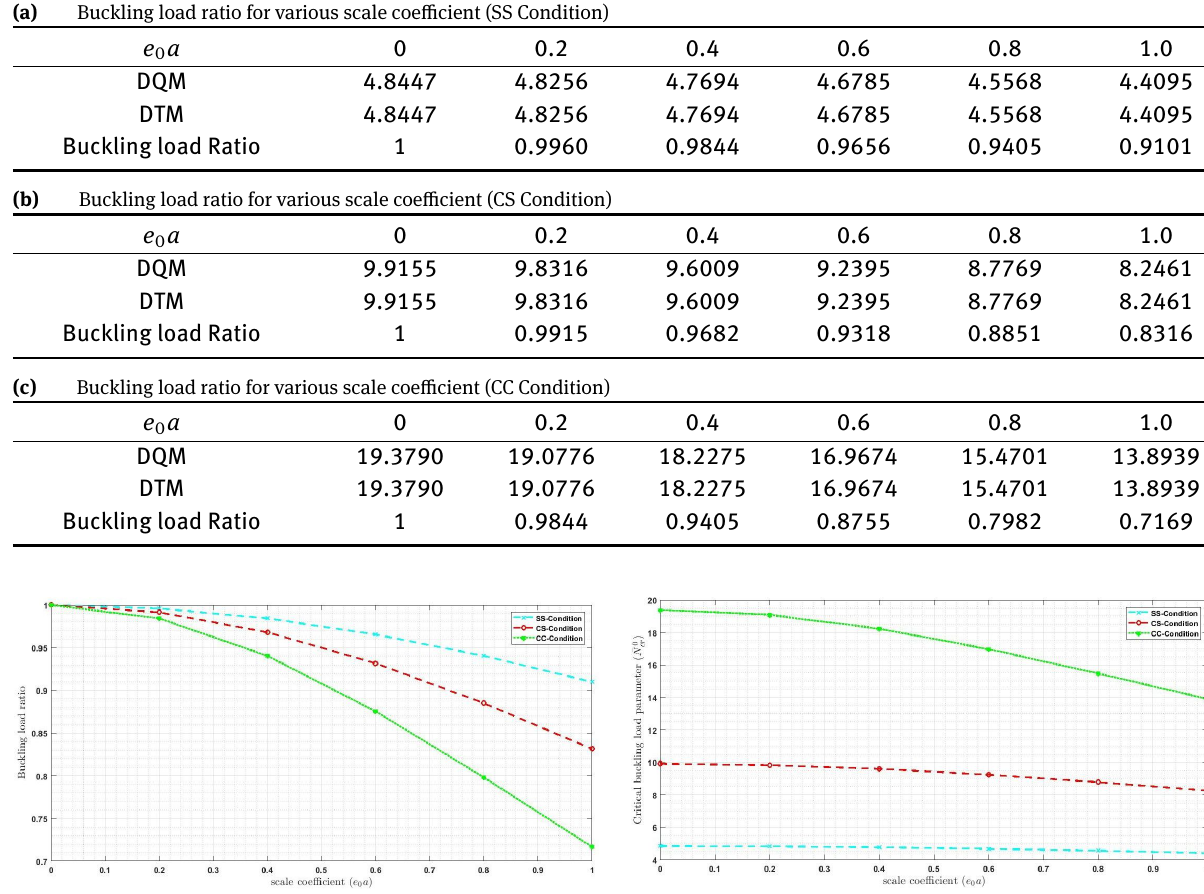
Table 6 for the boundary conditions SS, CS, and CC.